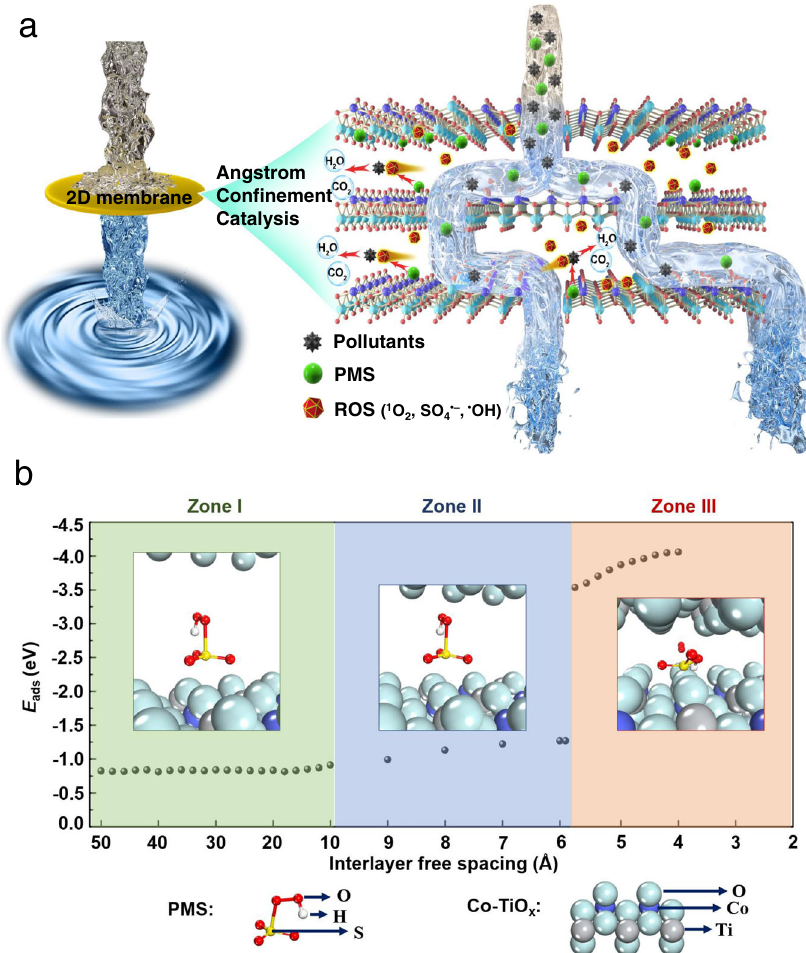
Fig. 1 Atomistic design of effective angstrom-con fi nement catalysis. a Schematic diagram of ACC in 2D laminate membrane. b Adsorption energy ( E ads ) of PMS molecule intercalating into the nanosheets of Co-TiO x membrane with the varied interlayer free